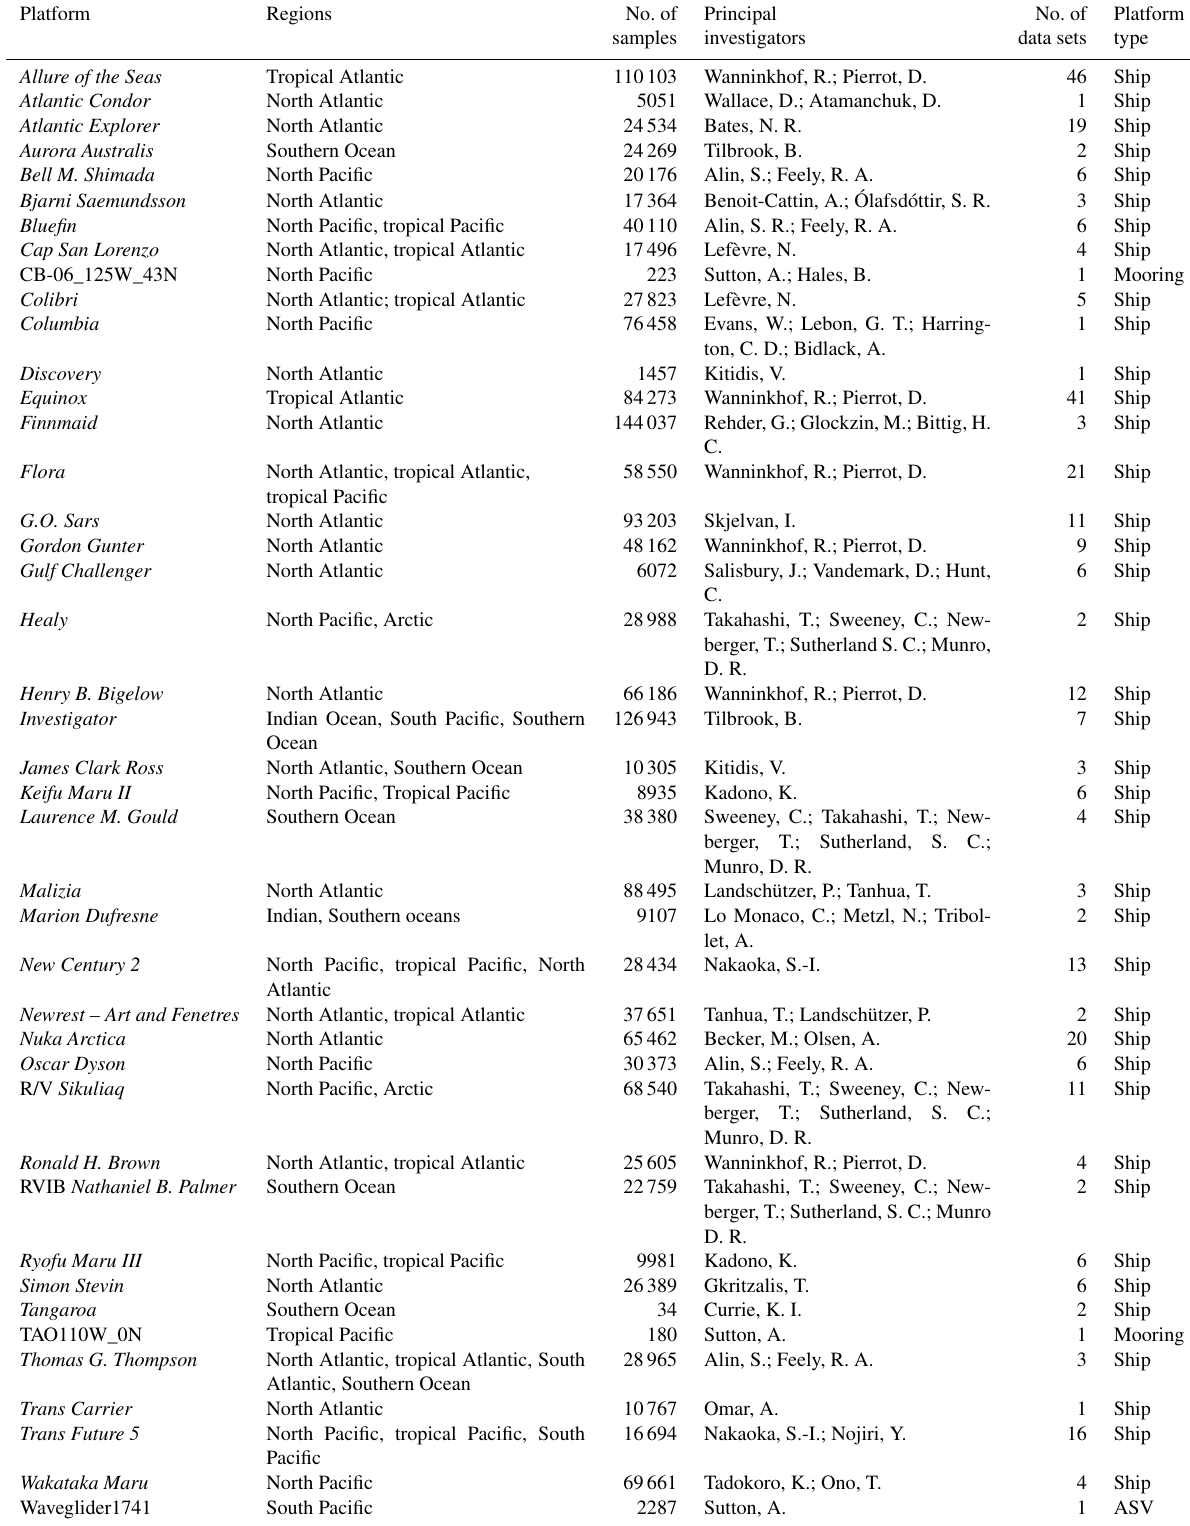
Table A5. Attribution of f CO 2 measurements for the year 2019 included in SOCATv2020 (Bakker et al., 2016, 2020) to inform ocean p CO 2 -based flux